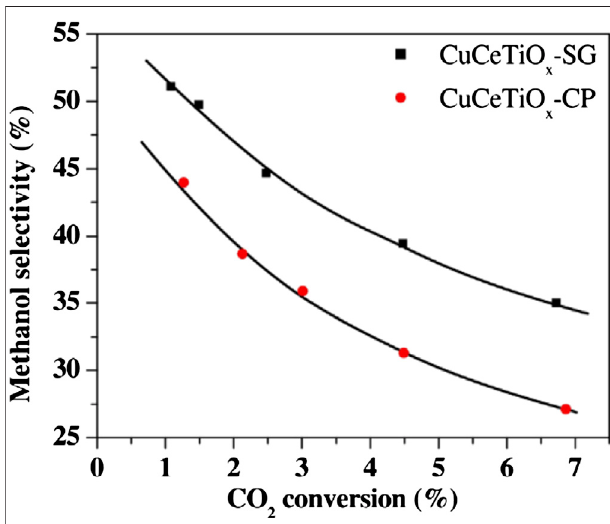
FIGURE 9 | Selectivity-conversion relationships of CuCeTiO x – SG and CuCeTiO x – CP (Chang et al., 2017). Reproduced with permission from